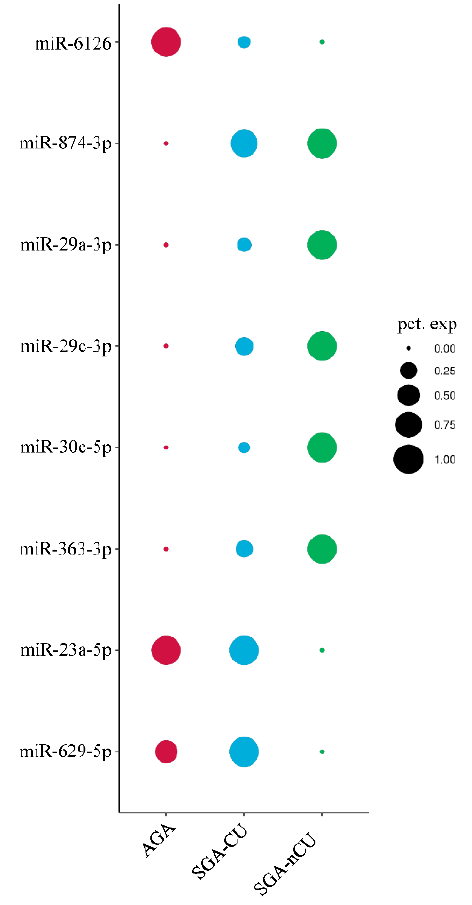
Figure 5. Schematic diagram of the average RPM percent expression of each miRNA in all groups.